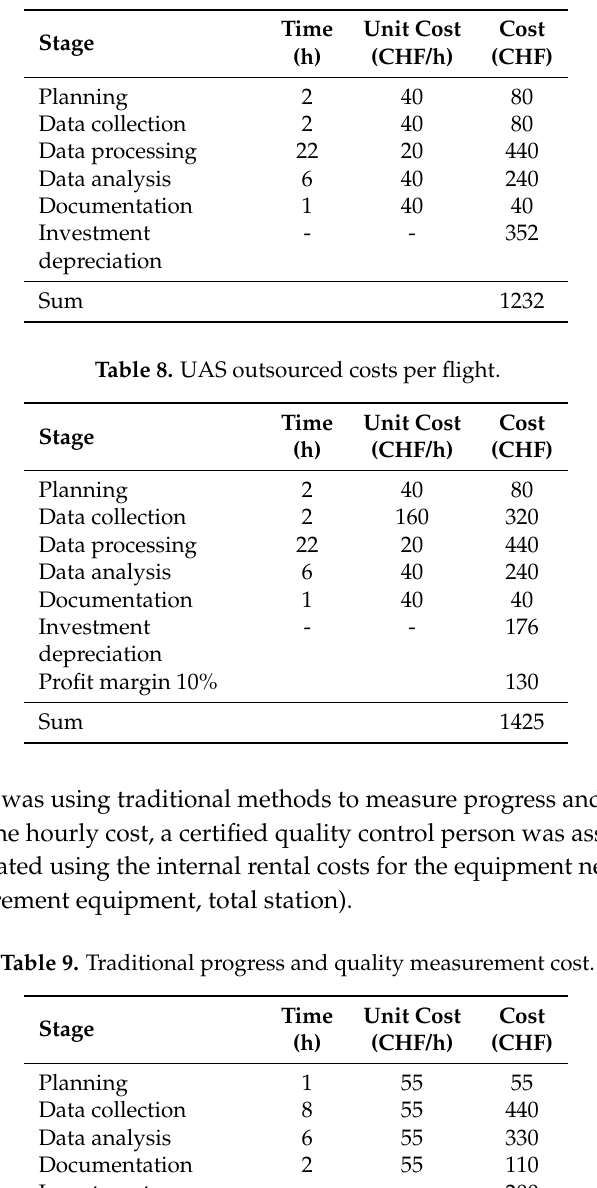
Table 7. UAS in-house costs per flight.